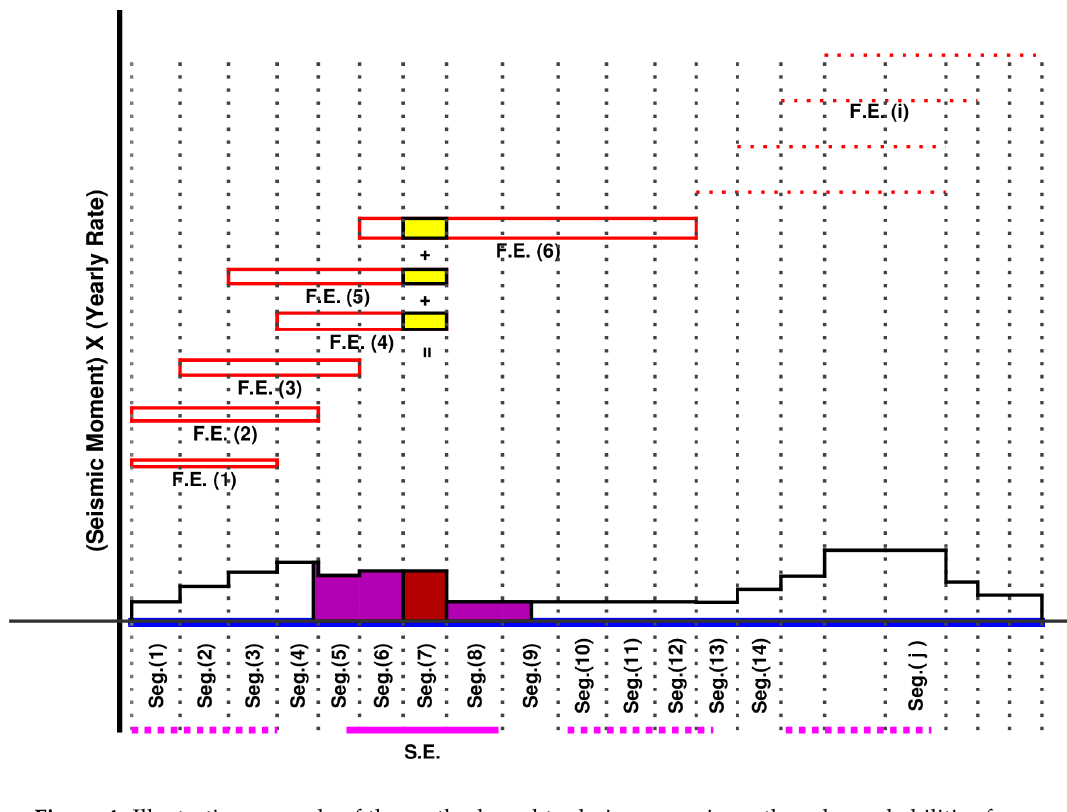
Figure 4. Illustrative example of the method used to derive scenario earthquake probabilities from forecast earthquake probabilities. Horizontal blue line: target fault. Dotted black lines: fault segmentation. Red unfilled rectangles: forecast earthquakes (F.E.) with seismic moment rates indicated by rectangle heights [step (ii) of method]. Yellow shaded region: seismic moment rate contributions of several forecast earthquakes to a given segment (step iii). Red shaded region: summation of yellow shaded regions (step iv). Magenta colored region: seismic moment rate of a scenario earthquake (S.E.) by summing the moment rates of all the segments (step v). Magenta lines: rupture extent of